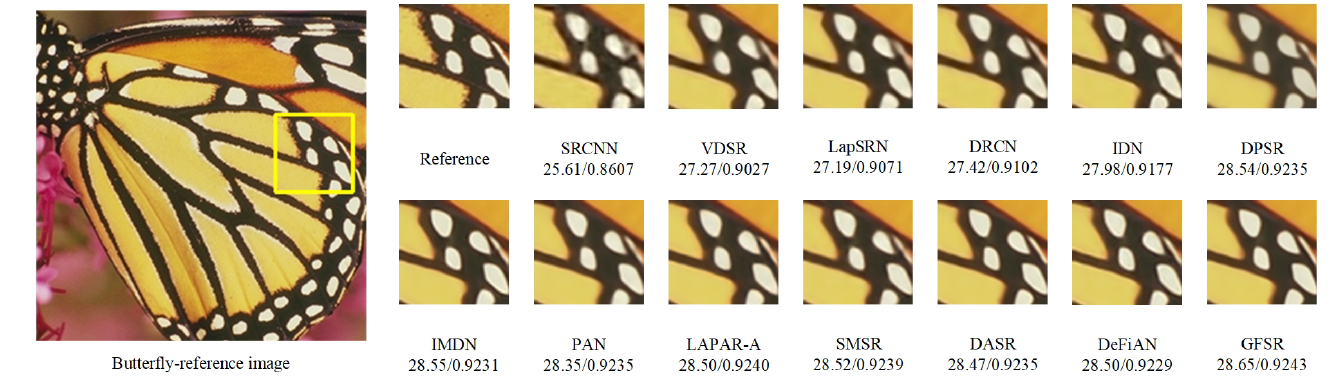
Figure 8. Visual comparison of super-resolution results of ‘Butterfly’ (Set5) obtained by different SR algorithms with scaling factor ×4.